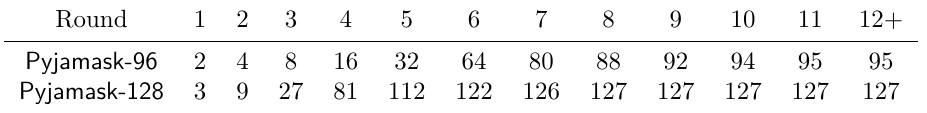
Table 3: Upper bounds on the degrees of each round of Pyjamask